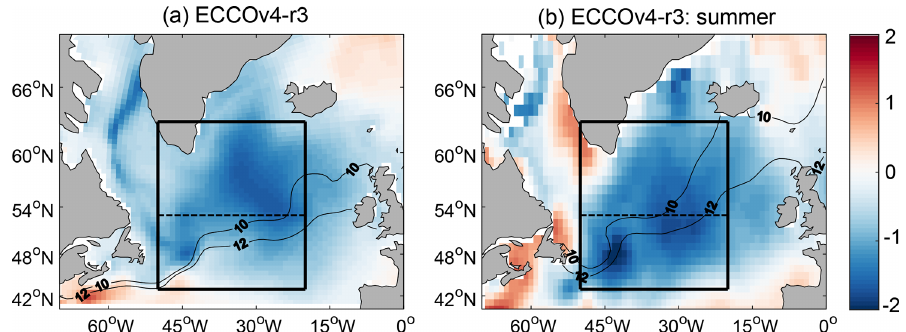
Figure B1. The SST anomaly ( ◦ C) in the ECCOv4-r3 monthly SST observations, relative to the 1992–2015 climatology, averaged over (a) the whole of 2015 and (b) the summer (JJA) only. The black boxes mark the region we use to define the extent of the 2015 cold anomaly (43–63 ◦ N, 50–20 ◦ W). The average position of the 10 and 12 ◦ C isotherms for each period is also shown.